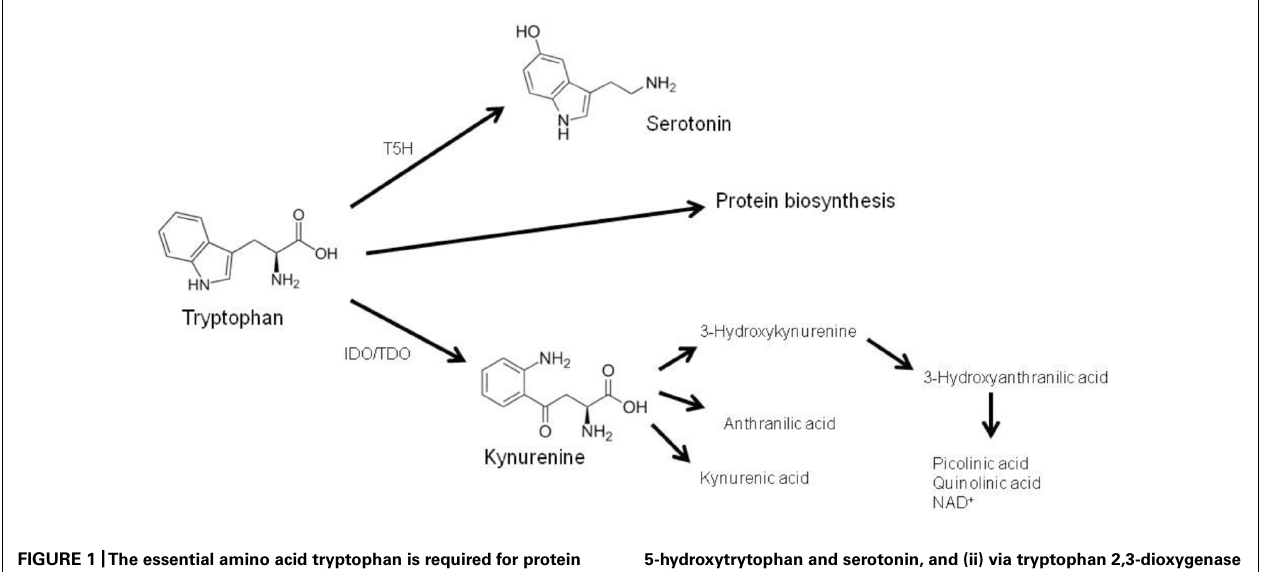
5-hydroxytrytophan and serotonin, and (ii) via tryptophan 2,3-dioxygenase (TDO) and indoleamine 2,3-dioxygenase (IDO) to kynurenine, which is fur- ther converted to several metabolites (adapted fromWidner etal.,